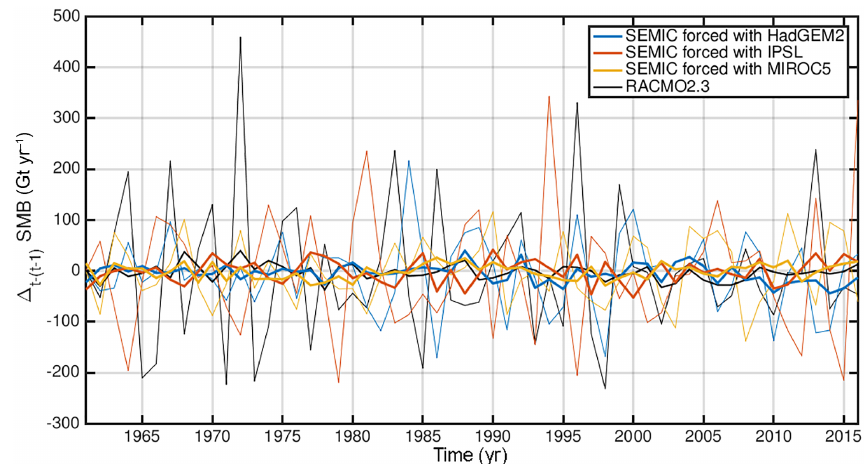
Figure 5. Inter-annual SMB variability for all SEMIC-GCMs (coloured lines) and RACMO2.3 (black line) calculated from consecutive years; (cid:49) SMB = SMB t − SMB t − 1 . The thick lines are a 30-year moving mean calculated from the yearly data (thin